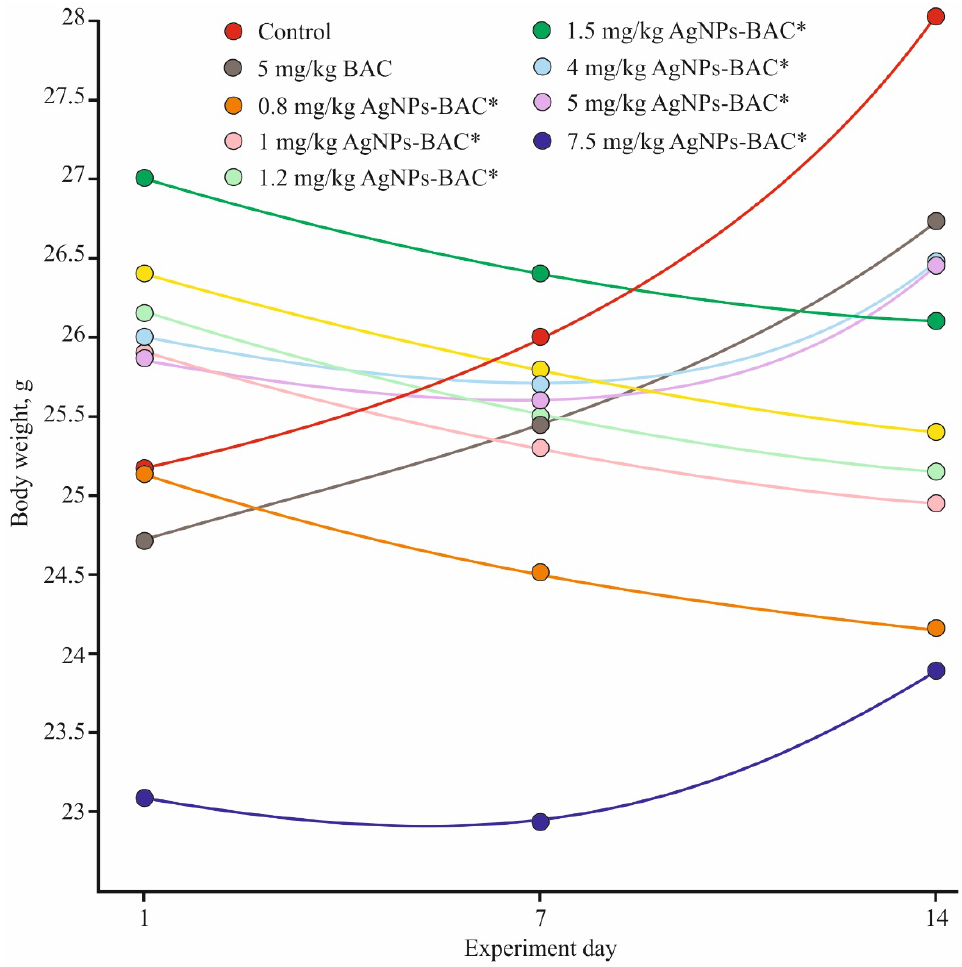
Figure 3. Weight gain dynamics in the acute experiment. * p < 0.01.